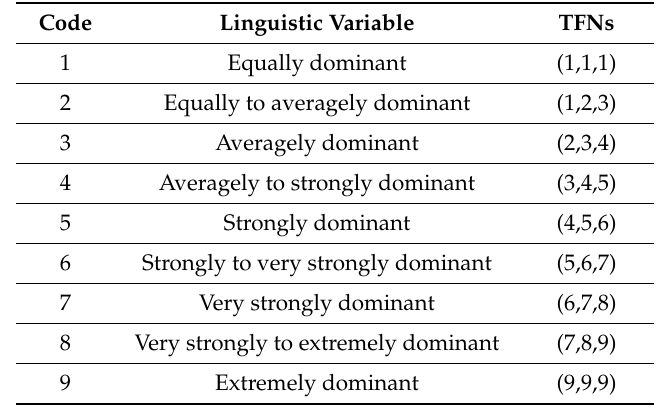
Table 3. The triangular fuzzy number (TFN) scale.